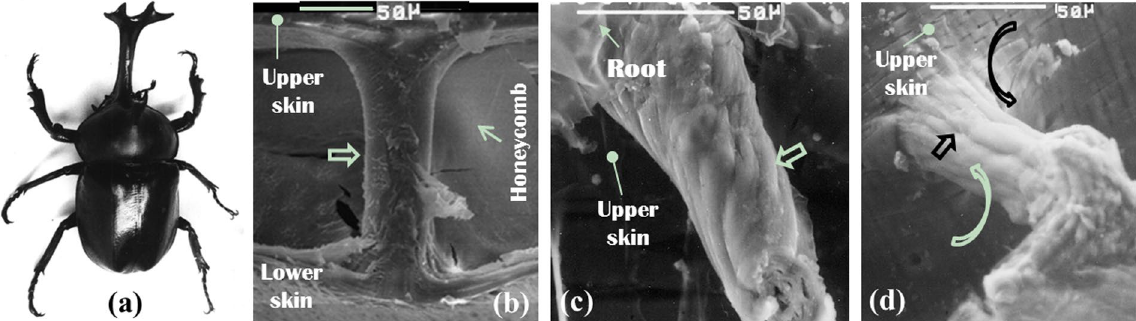
Figure 1. The beetle and microstructure of trabeculae. ( a ) An adult A. dichotoma beetle 21 . ( b ) The shape of a trabecula 18 . ( c , d ) The orientations of the chitin fibers on the outside of a trabecula 18 . Trabeculae as indicated by broad arrows.